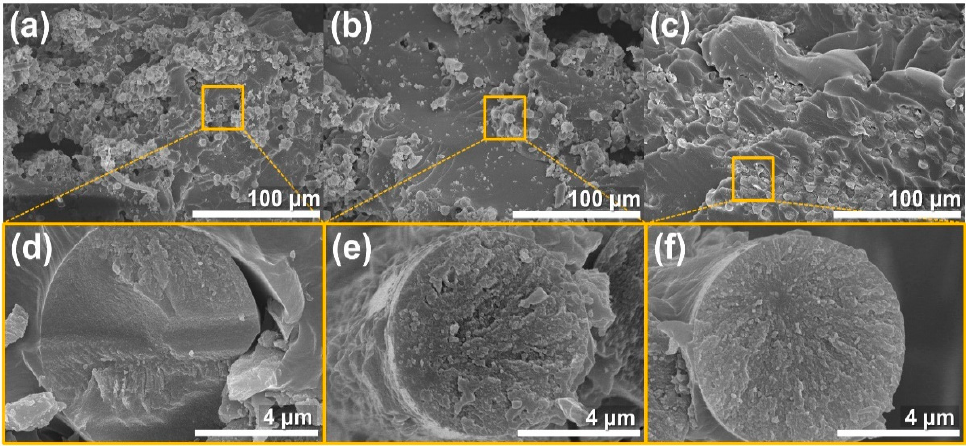
Figure 7. Fractured surfaces on SCE and P-SCE composites SEM images of ( a ) neat composites, ( b ) SCE3 composites, and ( c ) P-SCE3 composites: ( d – f ) are enlarged parts of the ( a – c ) image rectangles, respectively.